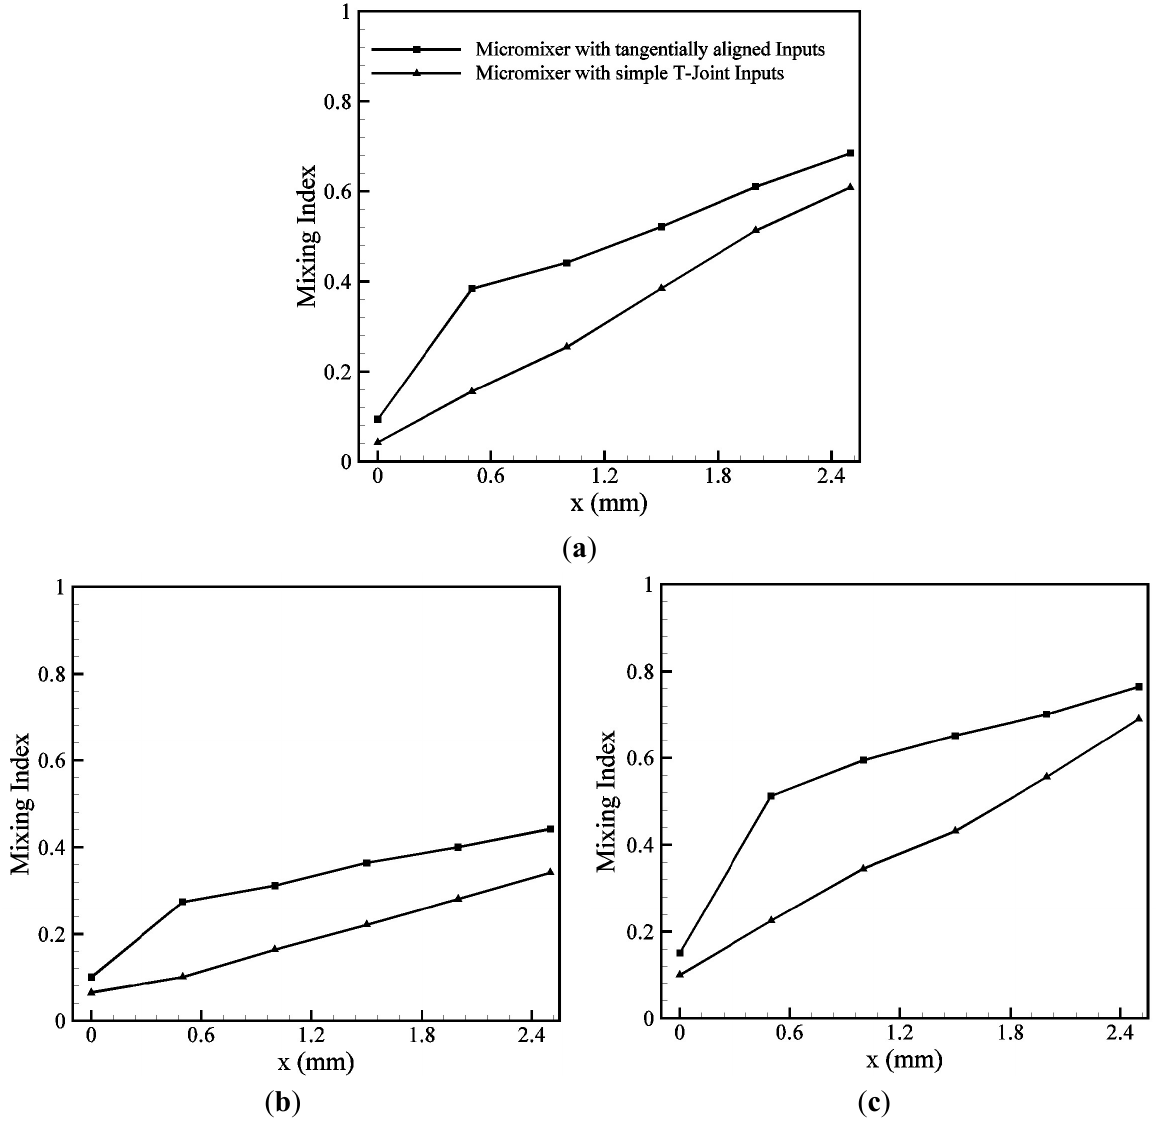
Figure 5. Mixing index distributions along the channel length at different